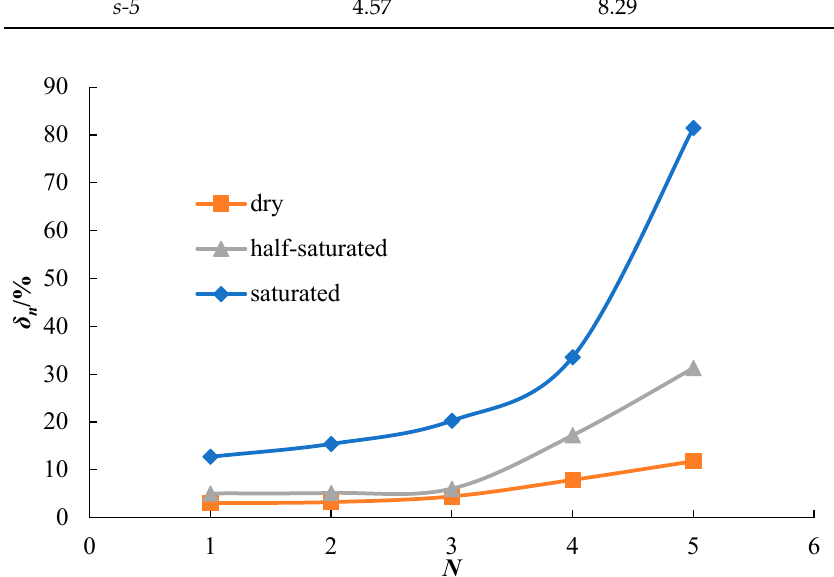
Figure 12. The relationship curve of porosity change rate—impact times.